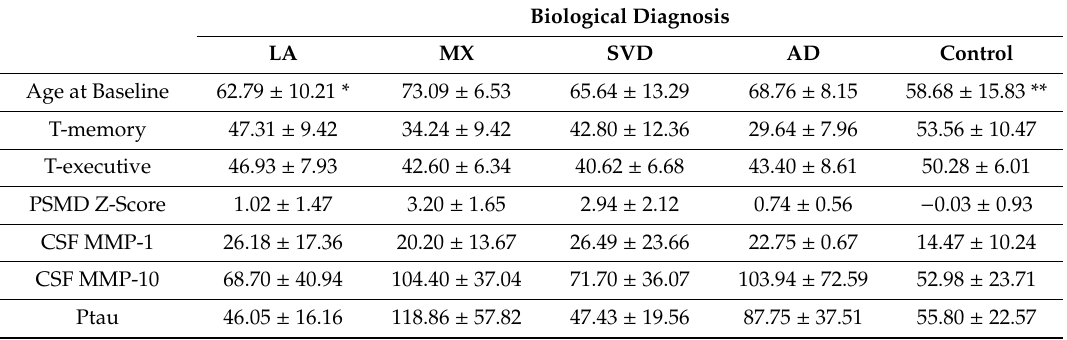
* All numbers are mean ± standard deviation. ** Statistical significance was present at the p < 0.05 level for all